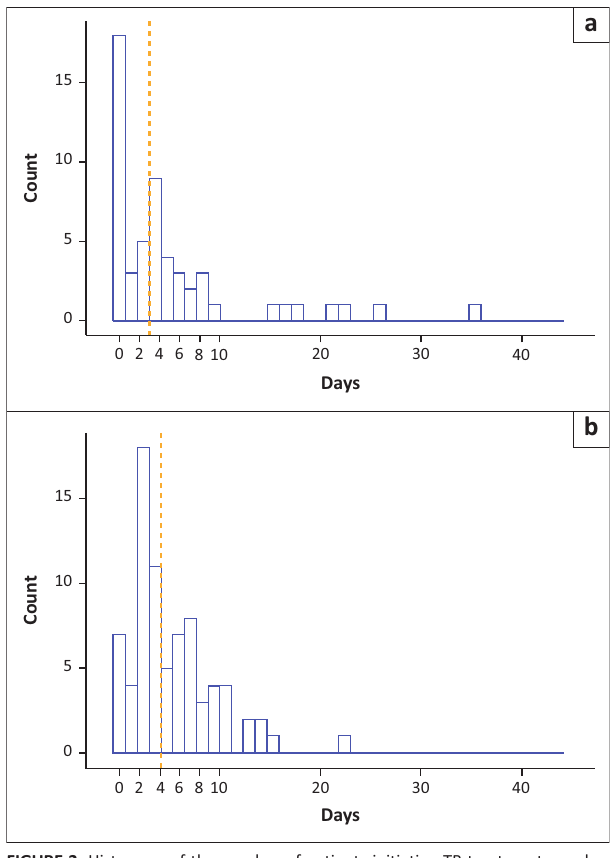
FIGURE 2: Histogram of the number of patients initiating TB treatment per day, over days 0–42 in the study, in (a) the prospective arm meeting criteria for inclusion in primary analysis and (b) the retrospective arm. Orange dashed line represents the median.